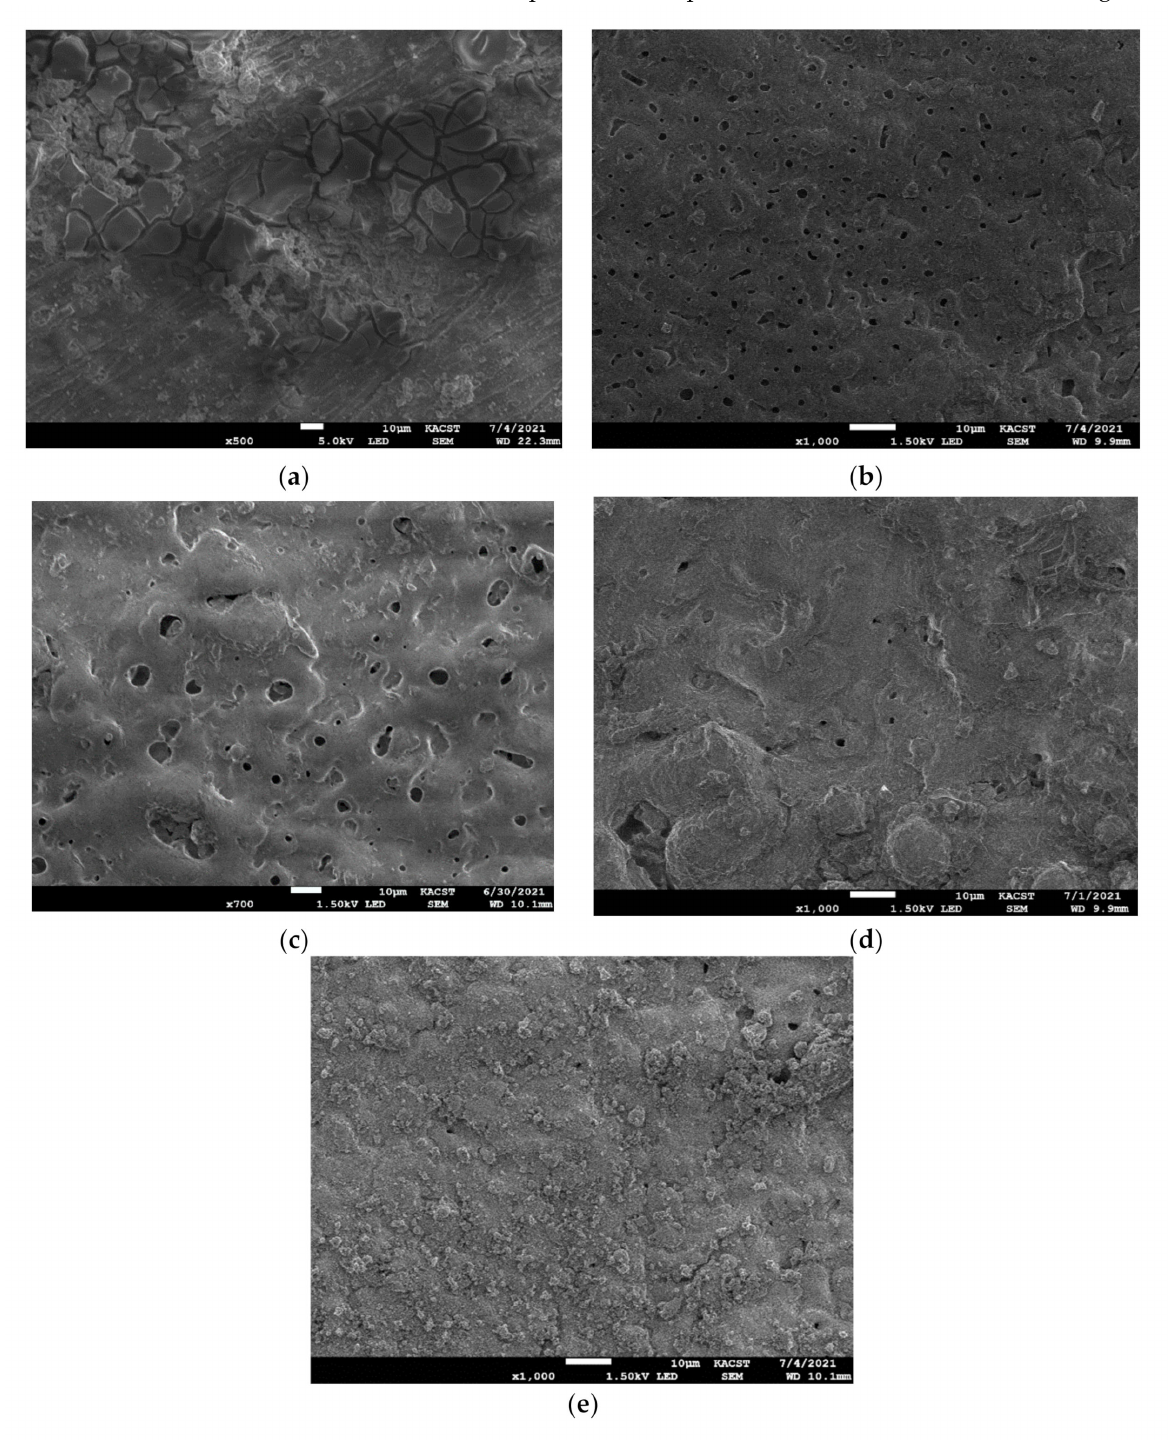
Figure 4. SEM micrographs after conducting the corrosion test of the AA2014 samples subjected to PEO coating under various conditions: ( a ) BM, ( b ) BP50, ( c ) SiC/UP30, ( d ) SiC/BP50_1000, and ( e )